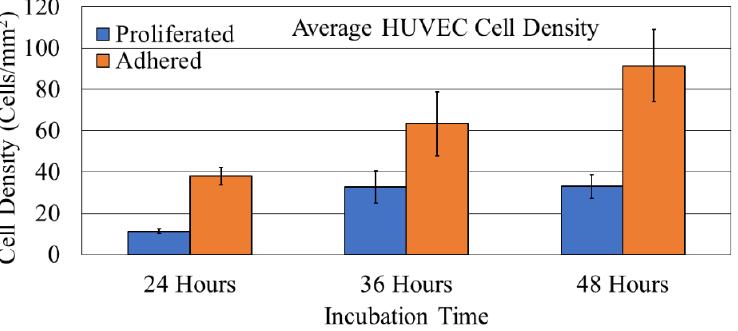
Figure 9. Average cell density ± 1 standard error bars of adhered and proliferated endothelial cells on Polycaprolactone (PCL) flow diverting stent (FDS) samples incubated for 24, 36, and 48 h.